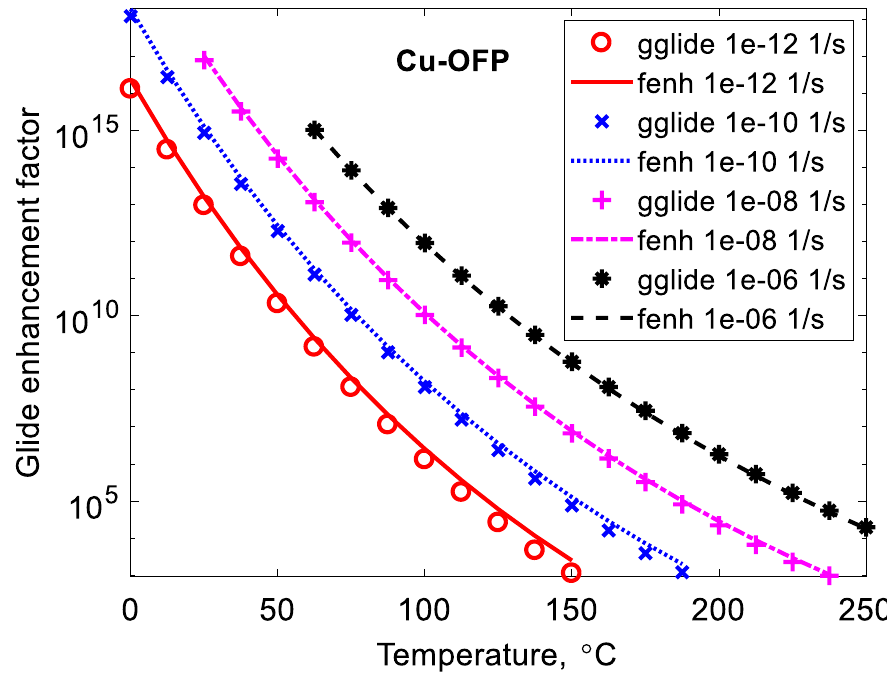
Figure 1. Comparison of the deformation induced increase in the vacancy concentration g glide , Equation (19), that raises the climb rate with the expression for the climb glide enhancement factor f enh , Equation (10). Results are presented for Cu-OFP at four strain rates. The corresponding comparison at different temperatures is given in Figure 2.